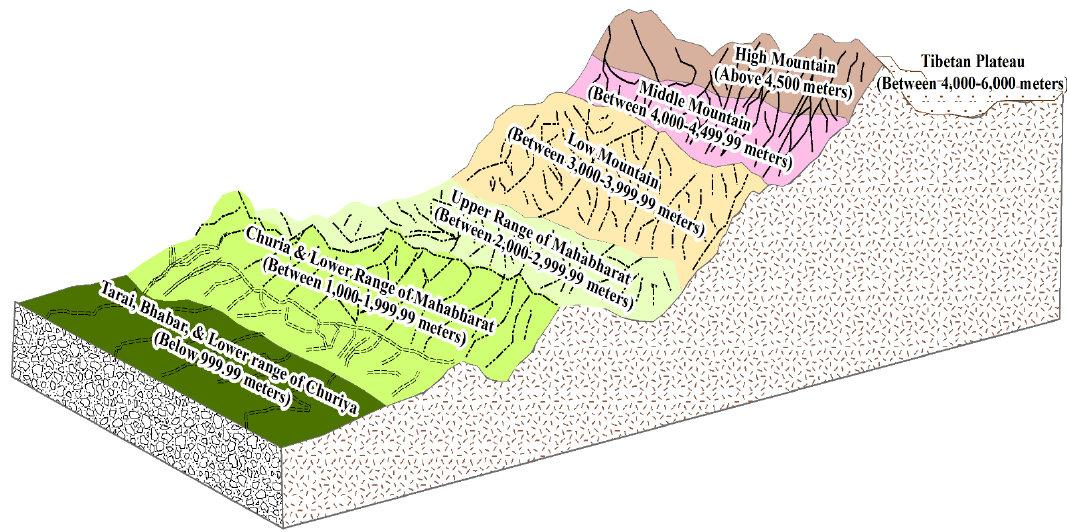
Figure 2. Cross-sectional view of physiographic divisions of Nepal.